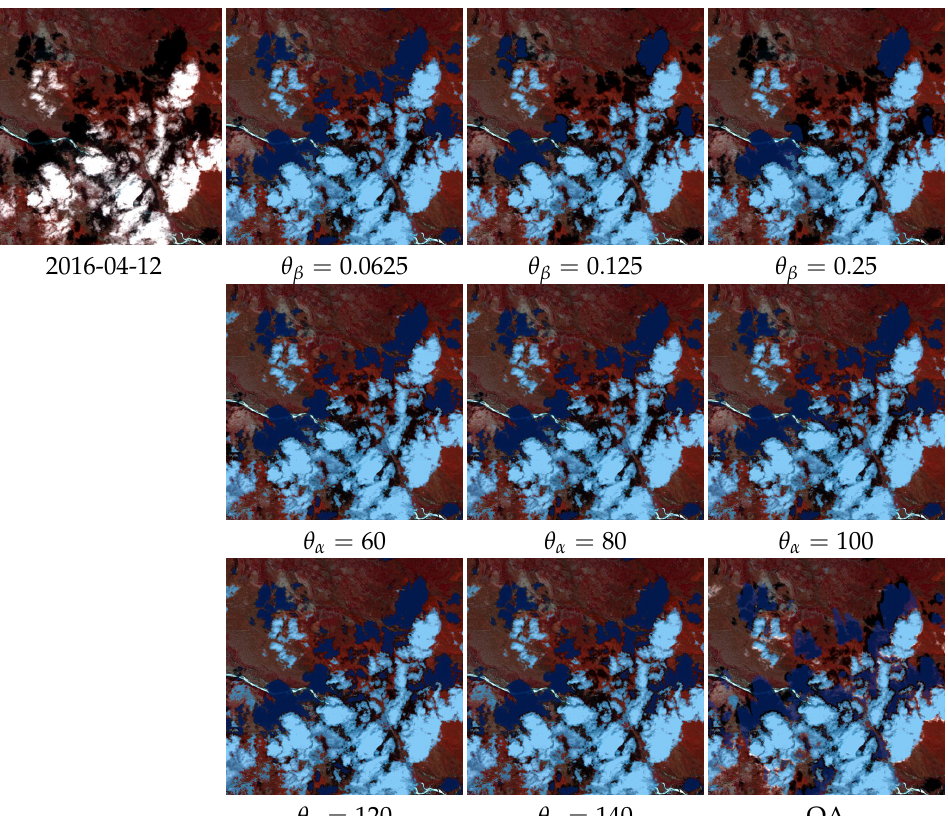
Figure 7. Typical visual examples in the hyperparameter test. We experiment with two key parameters θ α and θ β and visually evaluate their effects. CRF with a smaller θ β is more sensitive to edges, leading to more edge-precise proposals and tolerant preservation of potential shadow regions. On the other hand, θ α has a visually insignificant effect on the edge